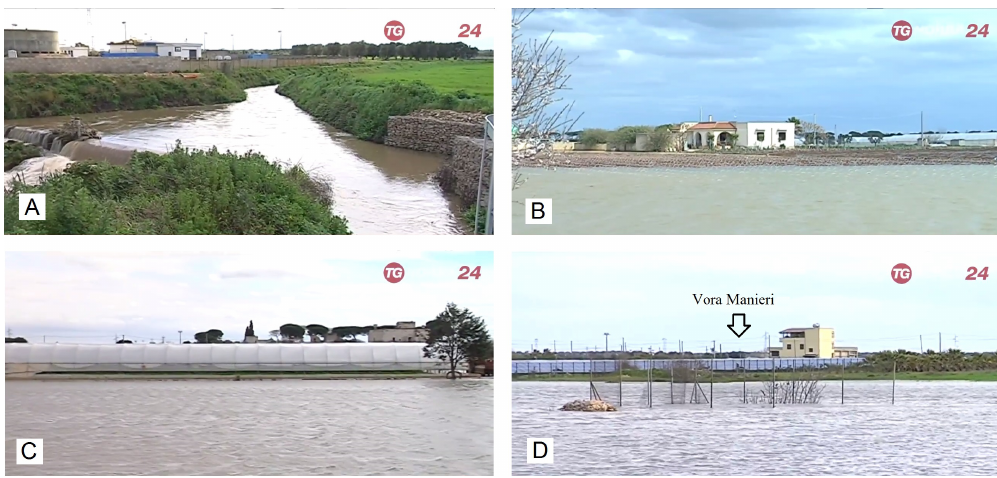
Figure 4. Pictures of the flood on 7 March 2015 [21]; ( A ) the torrent at the G2 sluice gate; note the overflow at the spillway on the left; ( B ) the flood reached a sub-urban zone; ( C ) flood damages in an agricultural factory; ( D ) the area around the swallow